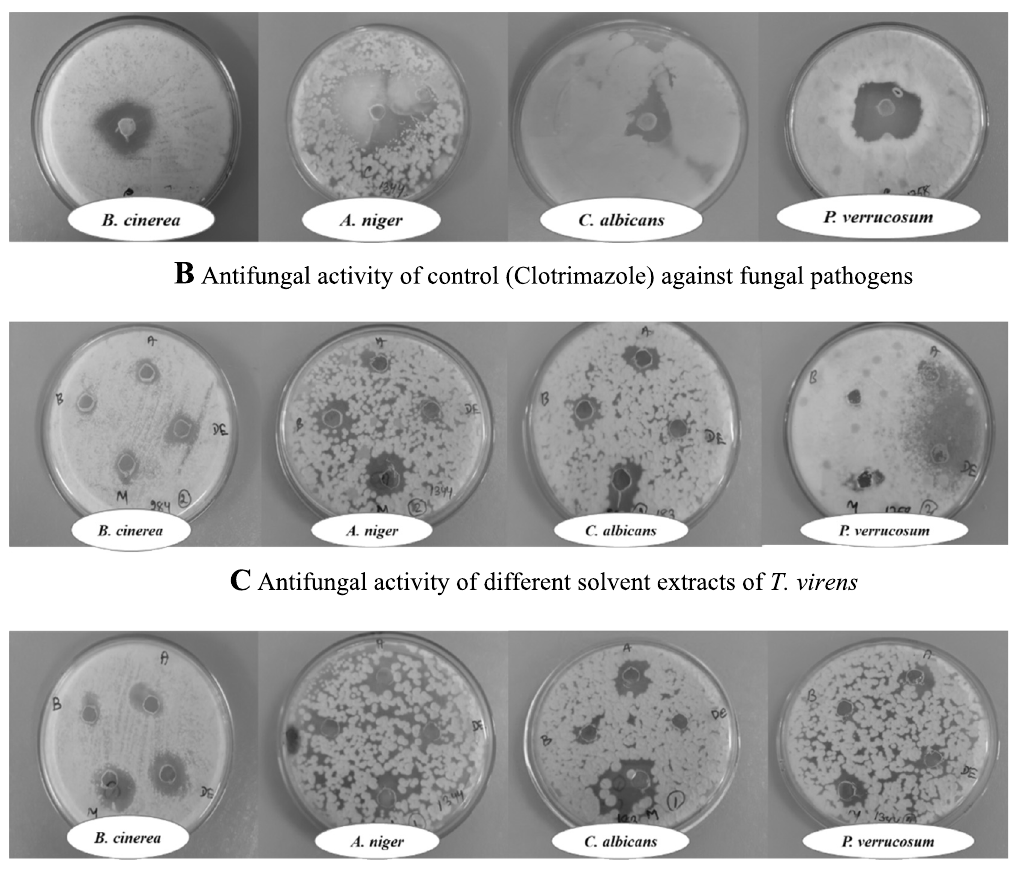
Fig. 11 A Antifungal activity of lichen against pathogenic fungi. B Antifungal activity of control (Clotrimazole) against fungal pathogens. C Antifungal activity of different solvent extracts of T. virens . D Antifungal activity of different solvent extracts of P.